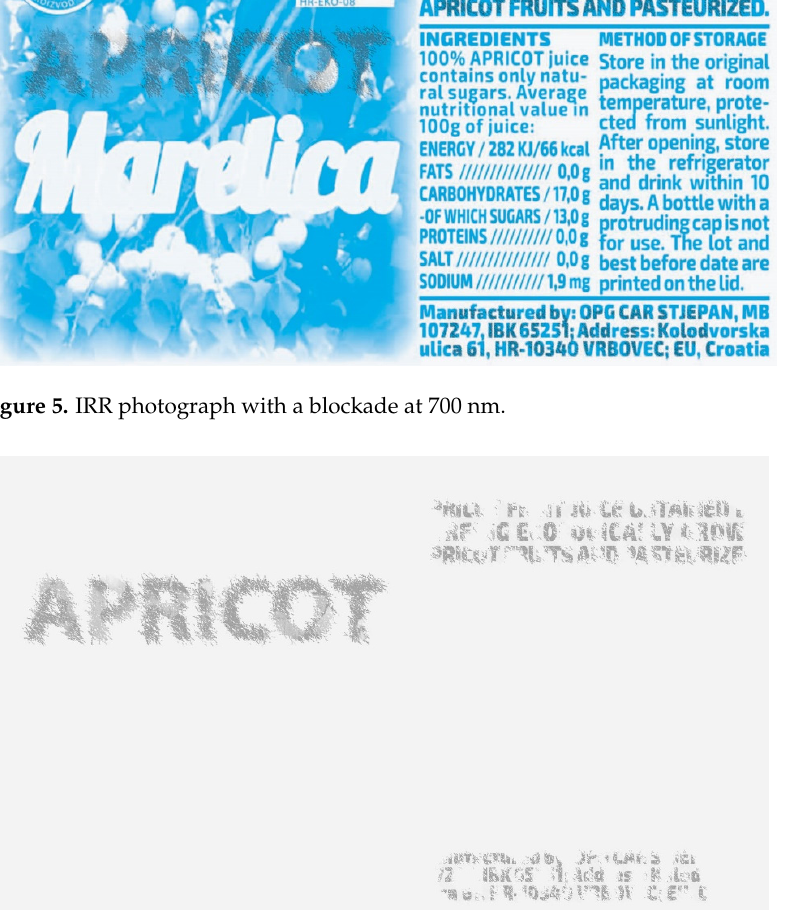
Figure 6. IRR photograph with a blockade at 1000 nm.